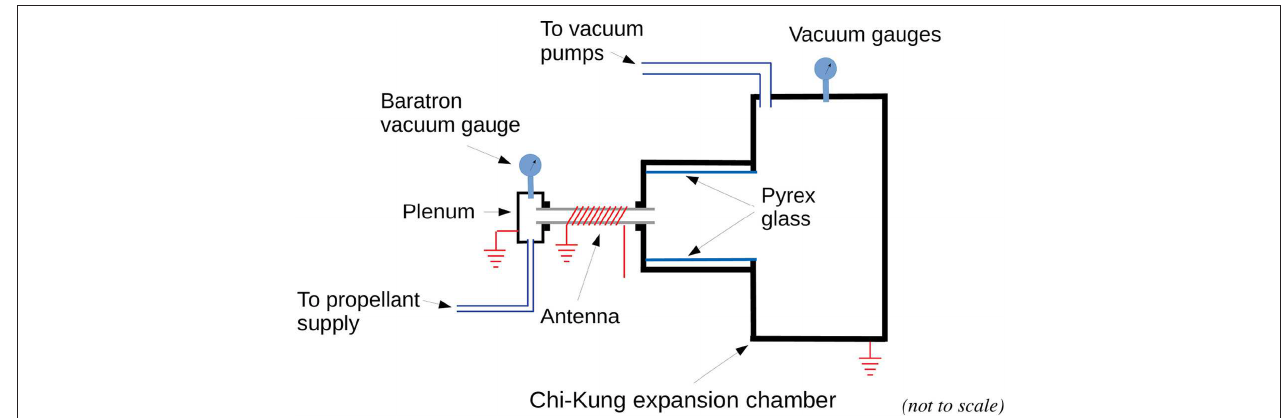
Frontiers in Physics |